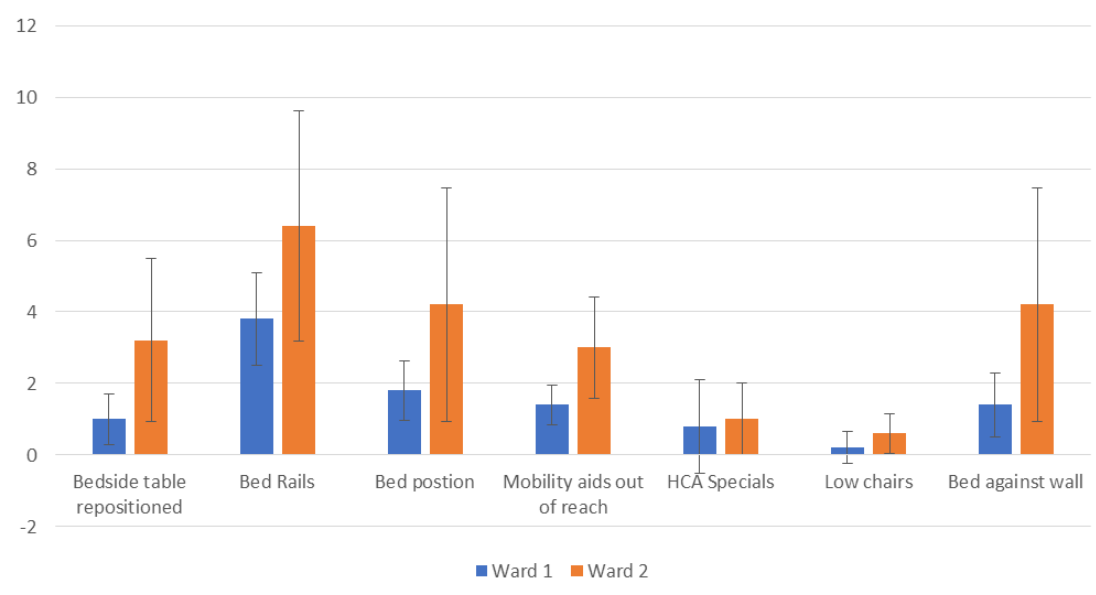
Figure 2. Average number of restraint instances per ward. Error bars represent standard deviation.